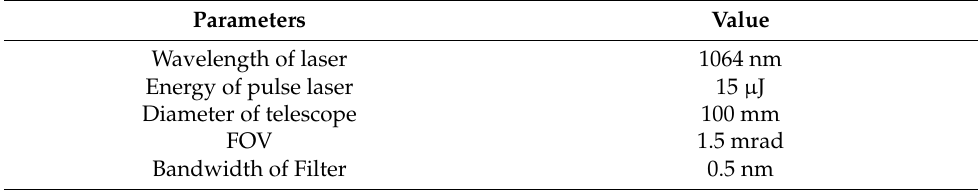
Table 2. Optimized optical parameters of